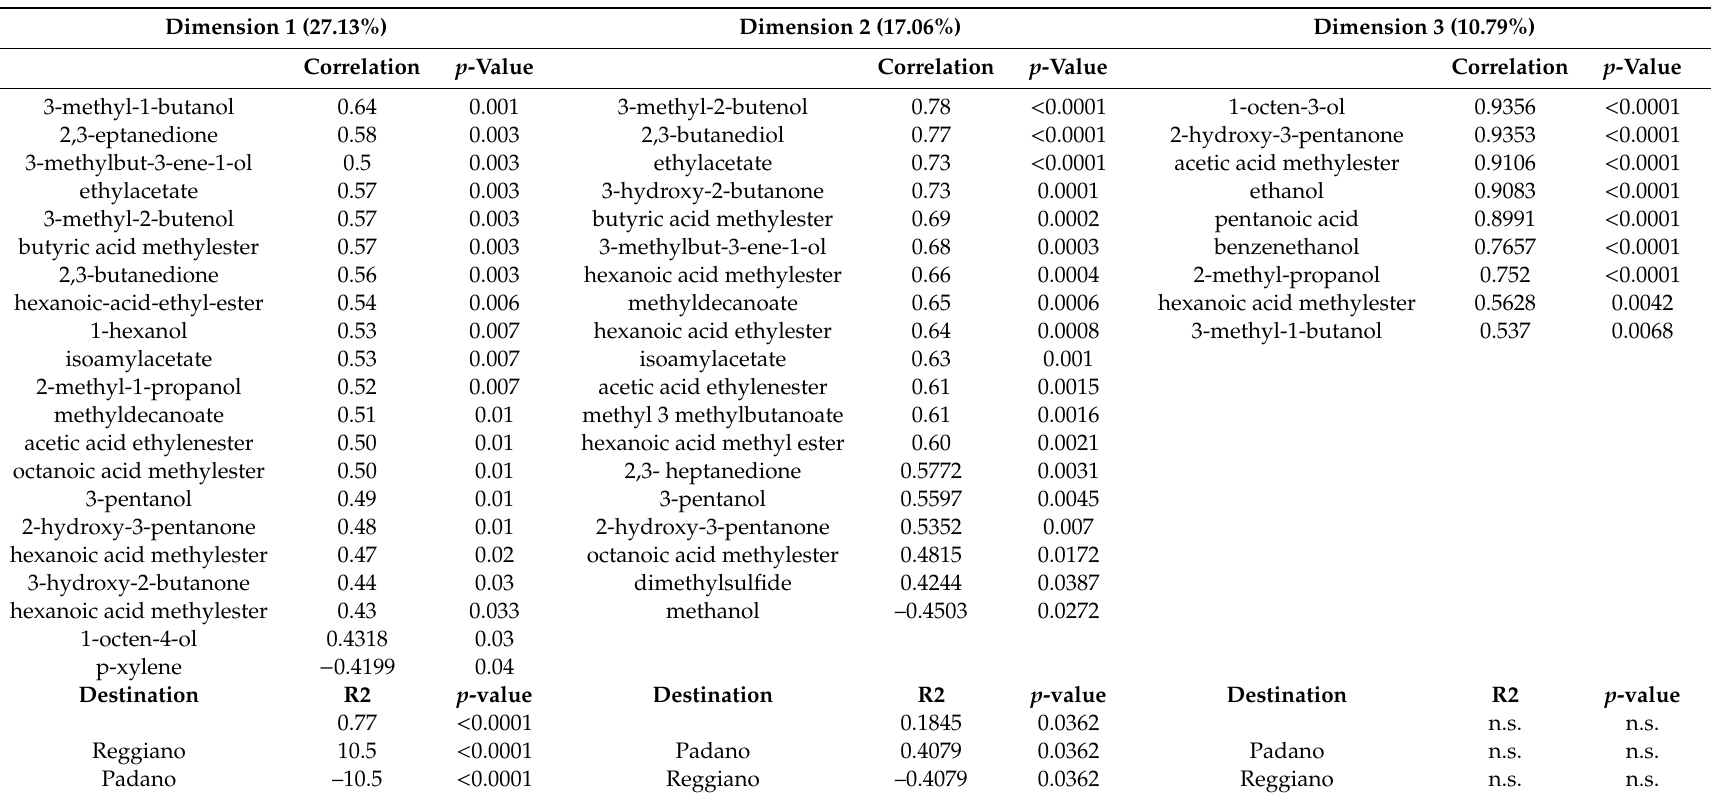
Table 3. Correlation summary for the first five dimensions of MFA analysis performed on single volatiles. Only significant correlations for each dimension are reported. The table also reports the correlations of the two destination milk groups (Parmigiano Reggiano or Grana Padano) with the